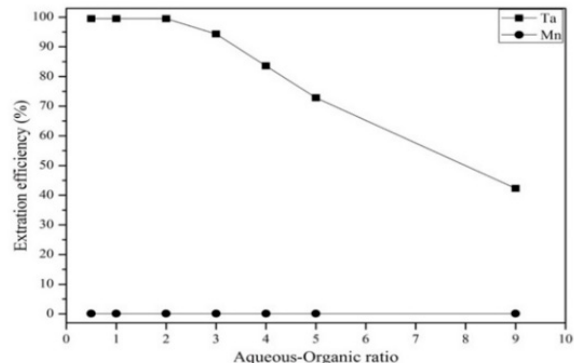
Figure 11. Effect of different aqueous–organic ratios on the extraction efficiency. pH 1. Extraction time: 5 min. Concentration: 0.025 mol/L.